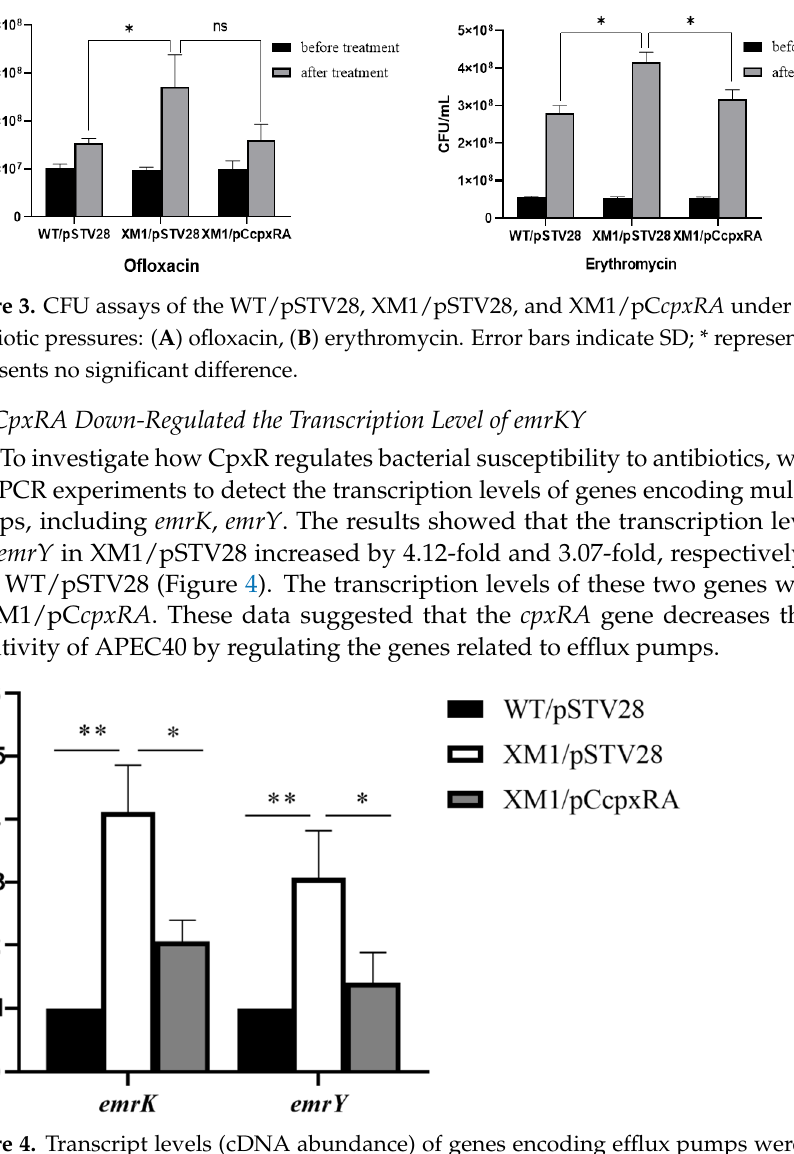
Figure 4. Transcript levels (cDNA abundance) of genes encoding efflux pumps were determined. The relative transcript levels of emrK and emrY in WT/pSTV28, XM1/pSTV28, and XM1/pC cpxRA